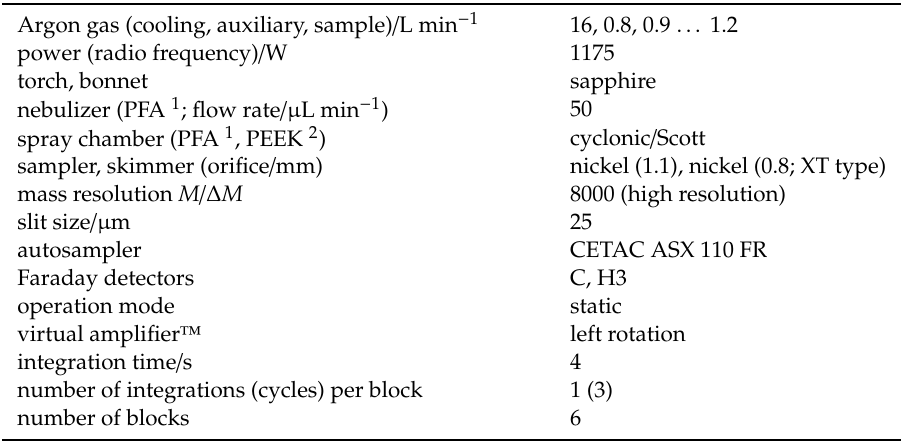
Table 1. Summary of the main operation parameters and instrument settings of the MC-ICP-MS. Argon gas (cooling, auxiliary, sample) / L min −